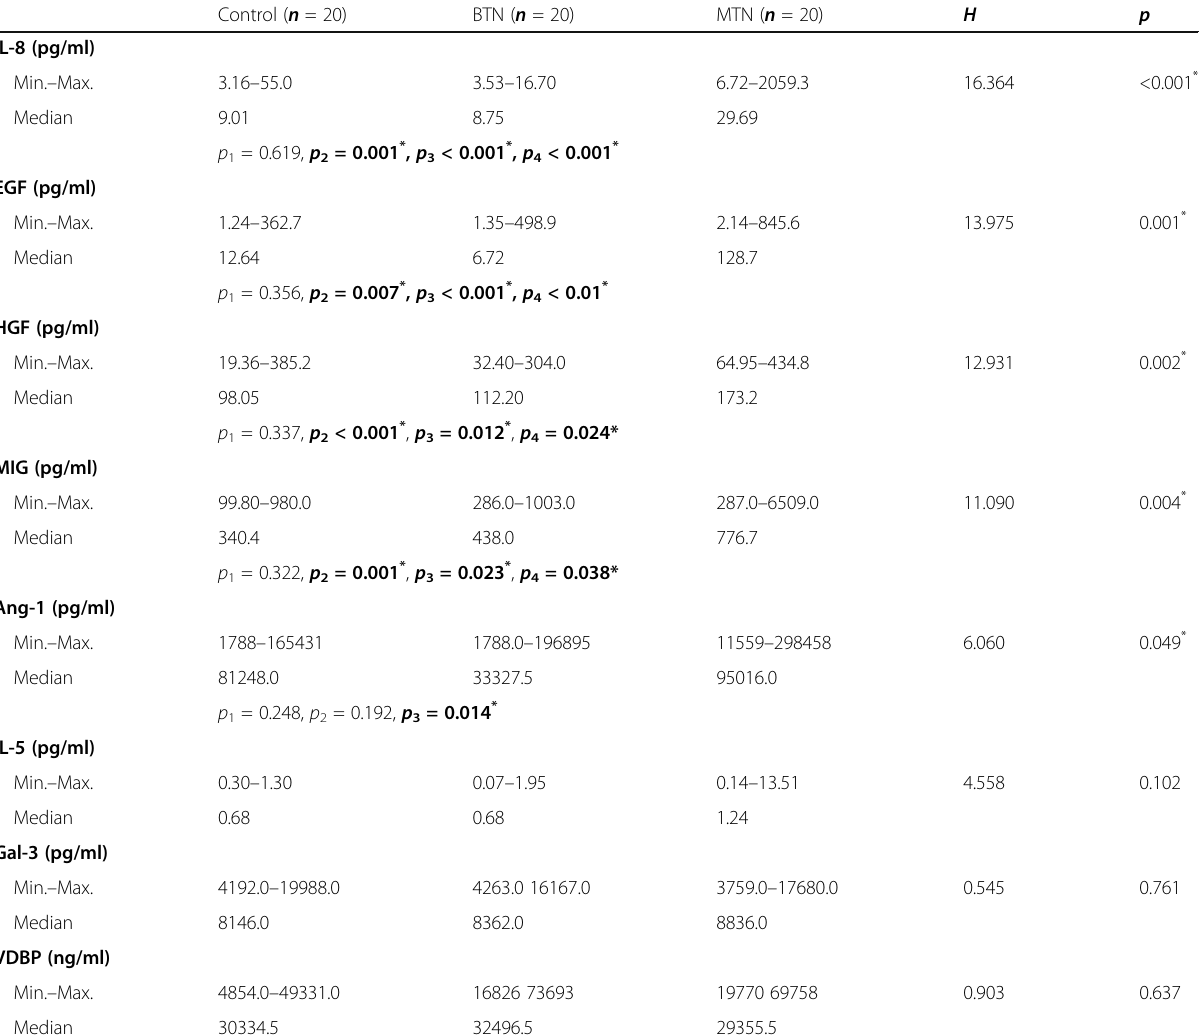
Table 3 Comparison of serum marker levels between the studied groups Control ( n = 20) BTN ( n = 20) MTN ( n = 20) H